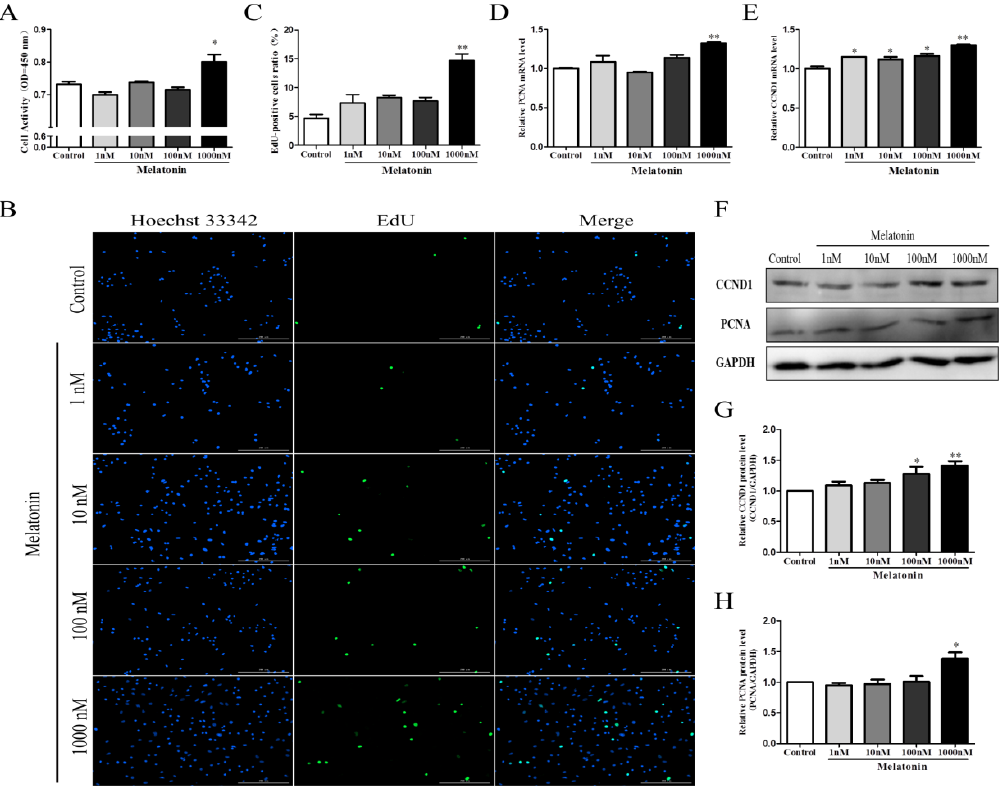
Figure 2. Effects of melatonin on the proliferation of chicken Sertoli cells. ( A ) Cell activity of chicken Sertoli cells (n = 3). ( B ) The EdU (5-ethynyl-2’-deoxyuridine) method was used to measure chicken Sertoli cell proliferation (×10 magnification; n = 3). ( C ) Statistical analysis of data in ( B ). The relative mRNA expression levels of ( D ) proliferating cell nuclear antigen (PCNA) and ( E ) Cyclin D1 (CCND1; n = 3 for both). ( F ) The relative protein expression levels of CCND and PCNA. Quantitative analyses of the ( G ) CCND1 and ( H ) PCNA protein results (n = 3 for both). ** P < 0.01; * P < 0.05.